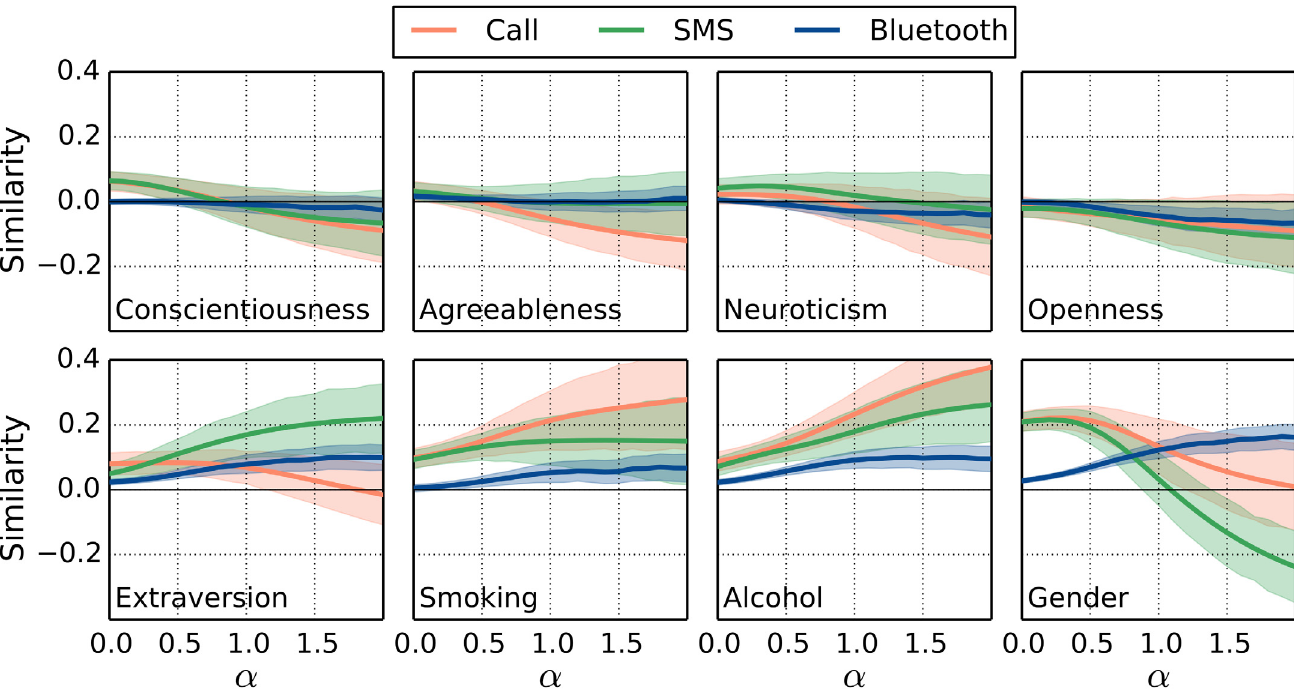
Fig 3. Computed similarity of individuals with different levels of social interaction. The computed similarity is shown as function of the parameter α , which tunes the weight of the individual links in the networks. The case α = 0 corresponds to the case of links having equal weight, whereas increasing values of α enhances the contribution from the stronger links in the calculation, e.g., for α = 2 the strongest links of each individual dominates. The envelope is the estimate of the standard deviation (see text). In S3 Text, a table is included of p-values for the individual traits and for different α - values. In general, the p-values are large ( > 0.05) for the traits Conscientiousness, Agreeableness, Neuroticism and Openness. The estimates of Extraversion attains lower p-values, e.g. for the BlueTooth, p (cid:2) 0.01, and for SMS the p-value varies in the interval 0.02 − 0.08 for different α -values.